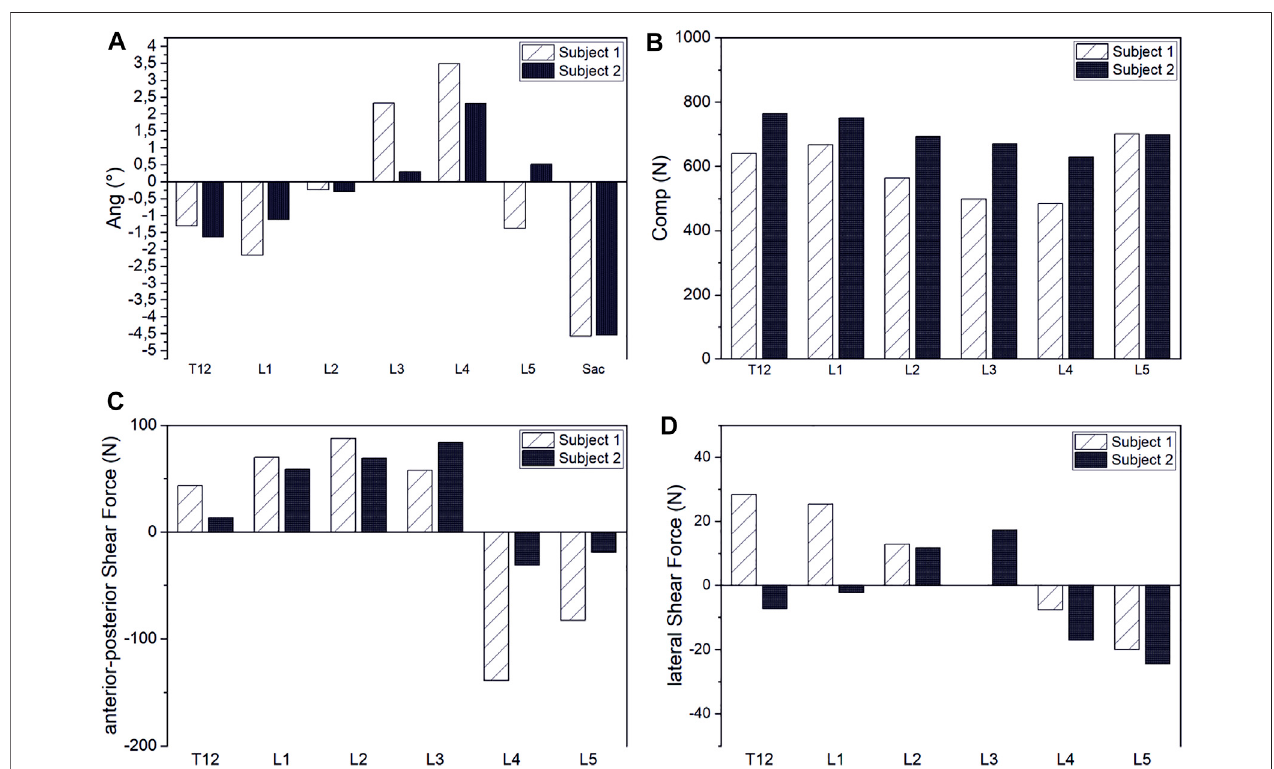
FIGURE 12 | Interindividual comparison of compensation angles for upright standing (A) and intervertebral jointcompression (B) , anterior – posterior shear (C) and lateral shear forces (D) .